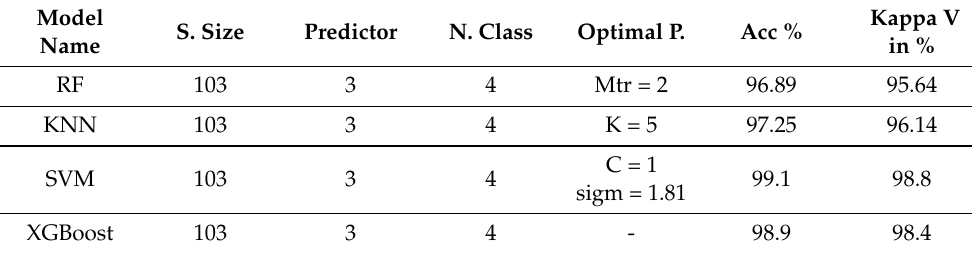
Table 1. Summary of base classifiers accuracy on the training datasets Model